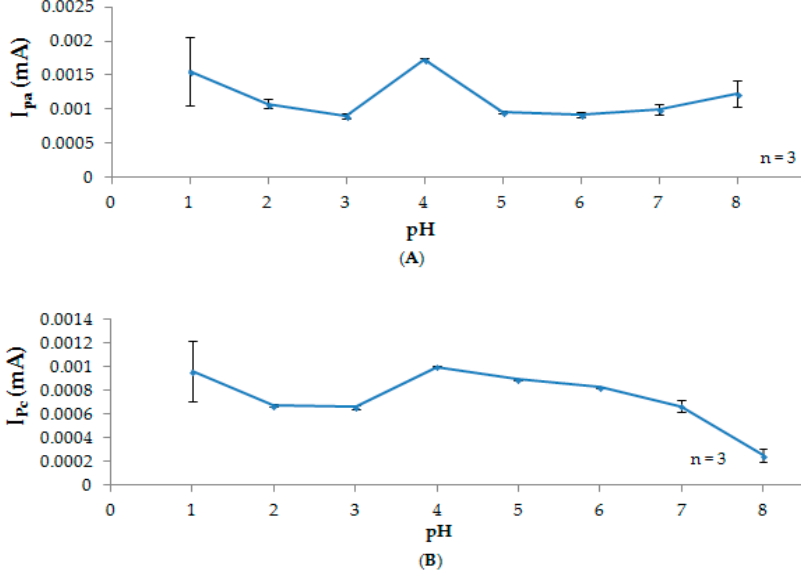
Figure 7. Effect of current as a function of pH. ( A ) Anode current. ( B ) Cathode current. Not visible error bars: when the symbol size is larger than the error bar.